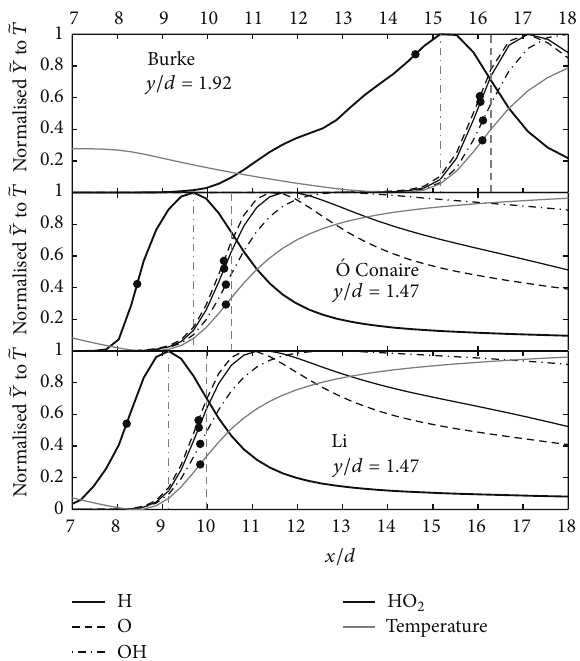
Figure 16: Axial profiles of the normalised Favre-averaged tempera- ture and mass fractions of H, O, OH, and HO 2 obtained at the radial locations of liftoff using the mechanisms of (from top to bottom) Burke et al. [42], ´O Conaire et al. [43], and Li et al. [41]. The vertical dash-dotted and dashed lines correspond to the axial locations of maximum HO 2 and liftoff, respectively. The circles indicate the locations of the maximum slopes. The CSDR is modelled using Girimaji’s model and 𝑇 𝑐 = 1045